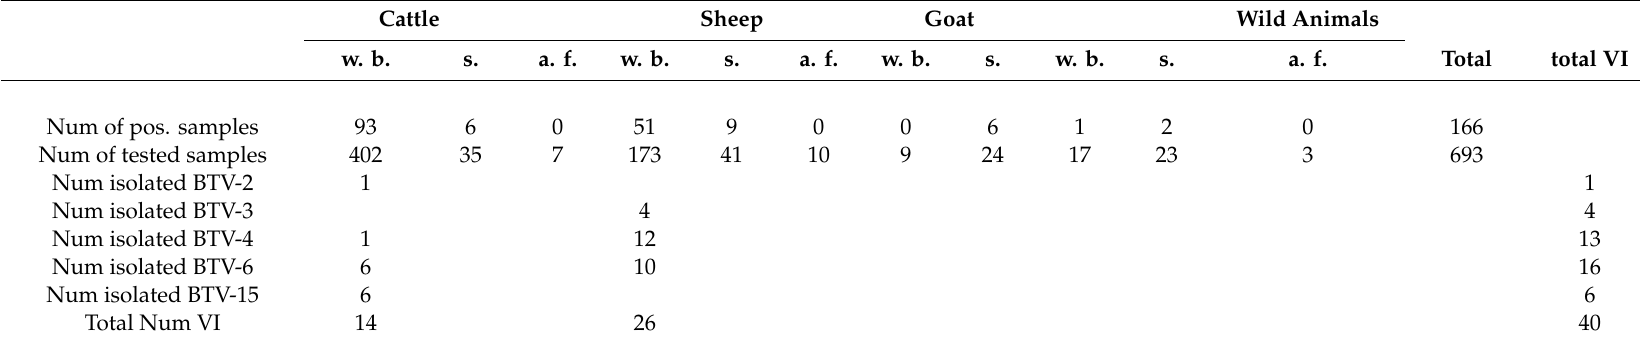
Table 2. Field samples, tested by Pan-BTV RT-qPCR, from di ff erent kinds of domestic and wild / zoo ill or dead animals and subsequent virus isolations during 2017. Cattle Sheep Goat Wild Animals